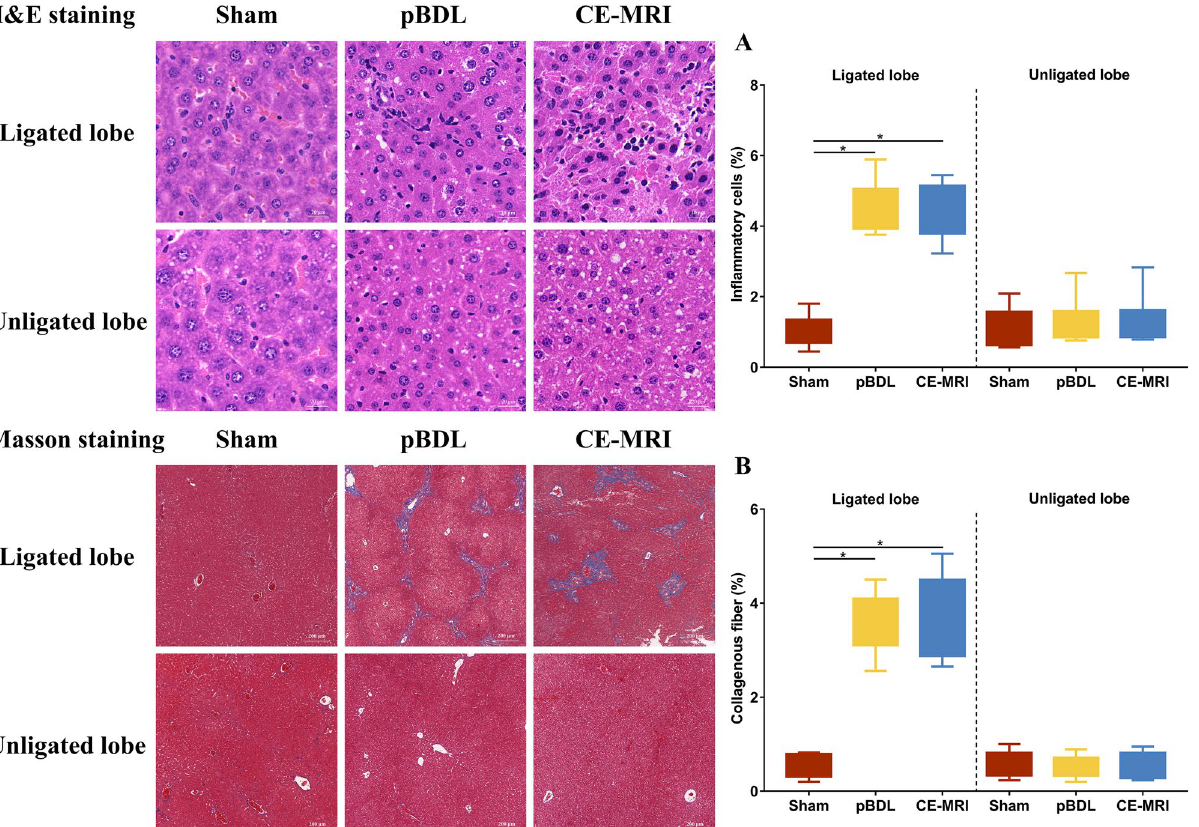
Figure 4. Lobe-specific changes in representative liver tissue from week 6 in the sham, pBDL, and CE-MRI groups comparing the unligated right lobe to the ligated left lobe in mice. ( A ) HE (original magnification, 400×) stain showing increased inflammatory cells (dark blue) in the ligated lobe of the pBDL and CE-MRI groups. ( B ) Masson stain (original magnification, 50×) showing significant fibrosis formation (collagen fibers, blue) in the ligated lobe of the pBDL and CE-MRI groups. HE, hematoxylin and eosin; Sham, only suture the abdominal wall. pBDL, partial bile duct ligation surgery alone; CE-MRI, repeated contrast-enhanced magnetic resonance imaging under anesthesia in the pBDL